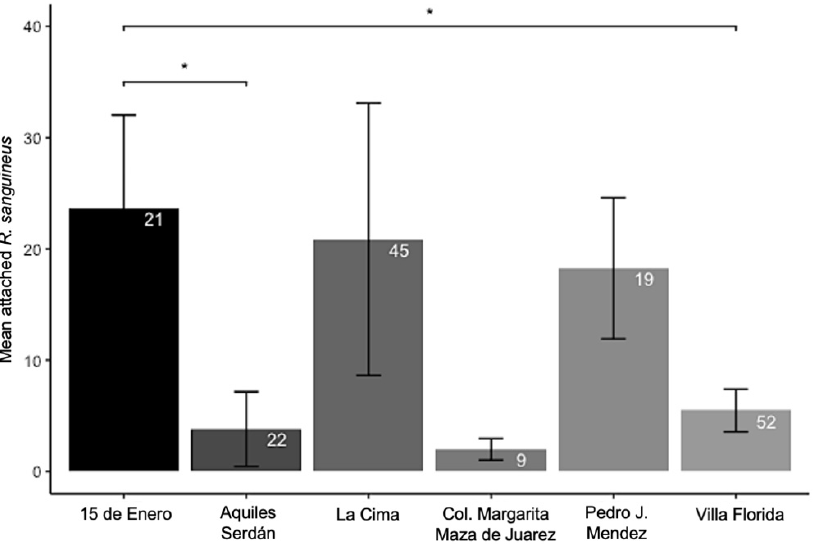
Figure 4. Mean attached Rh. sanguineus on dogs at each collection site. Error bars represent the standard error of the mean. The white number inside the bars represent how many dogs were enrolled in the study at each neighborhood. Significant differences are indicated as “*”, where p < 0.05.